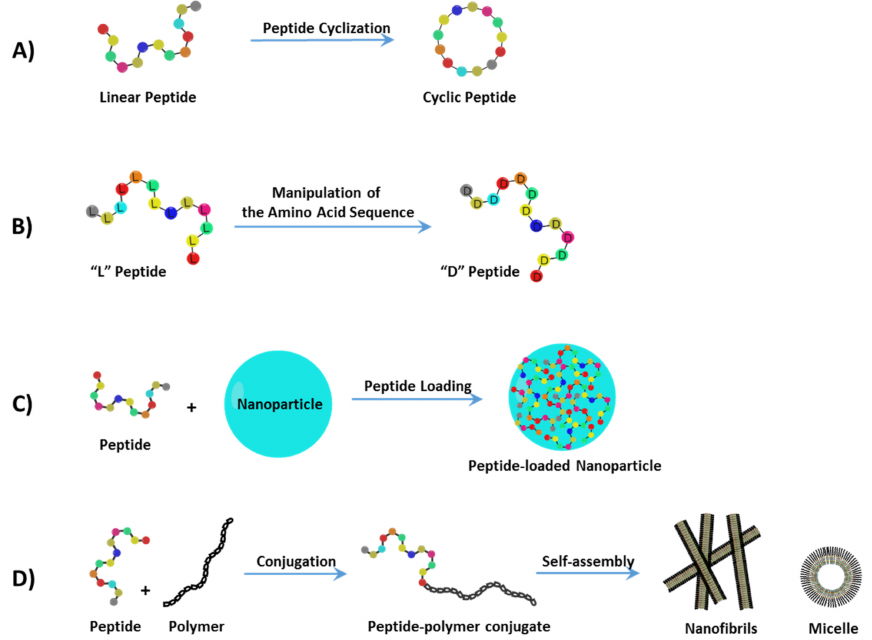
Figure 1. Current methods to enhance the half-life of peptide drugs and improve peptide drug delivery include ( A ) peptide cyclization, ( B ) manipulation of the amino acid sequence, ( C ) peptide- loaded nanoparticles, and ( D ) the conjugation of peptide drugs to natural or synthetic